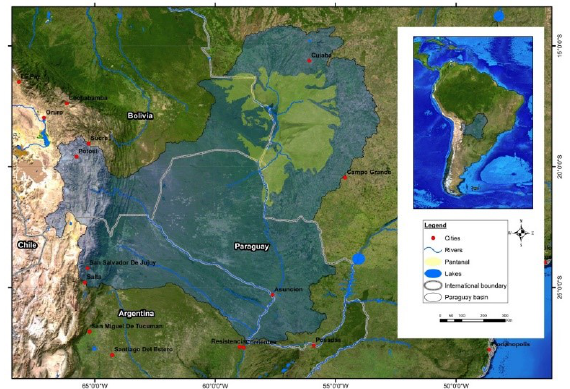
Fig. 1. Paraguay river basin and the Pantanal